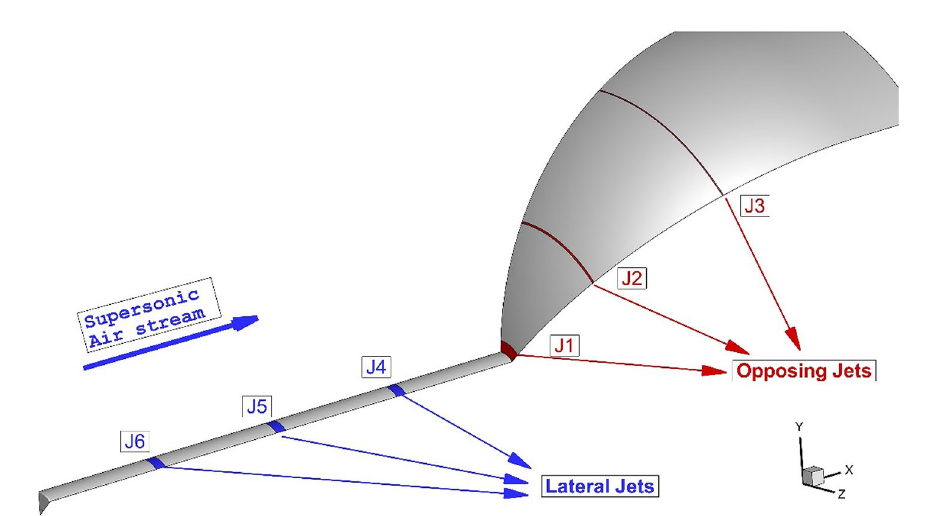
Figure 1. Schematic of the flowfield around the spiked nose cone with ( a ) lateral ( b ) opposing multi-jets.